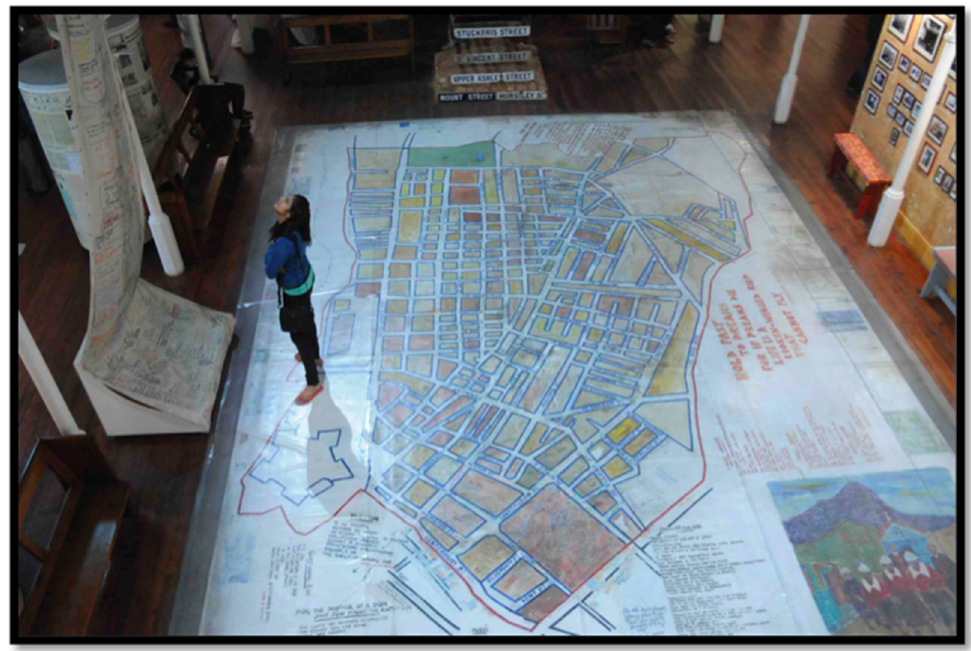
Figure 7 . The District Six Museum walking